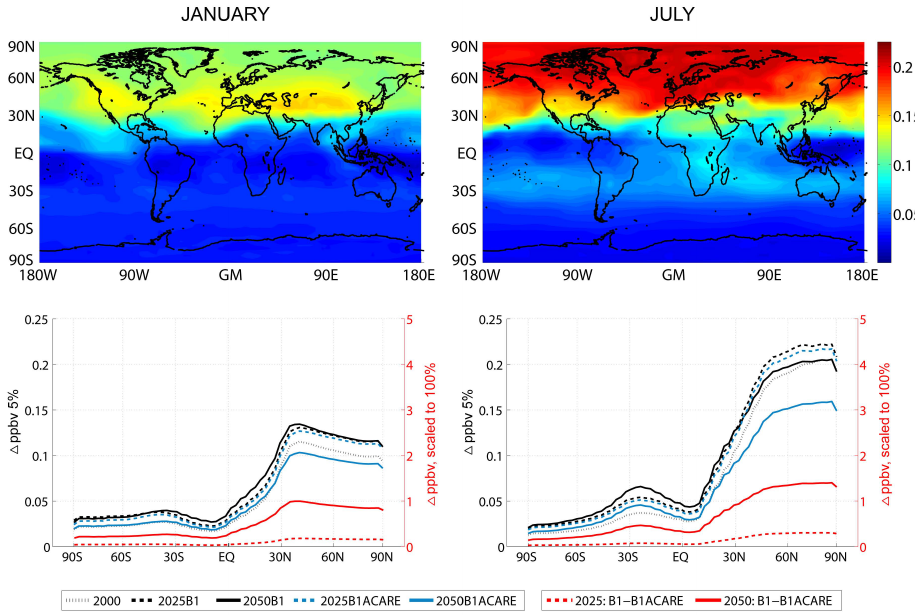
Fig. 6. Mean perturbations of ozone ( 1 ppbv) in the upper troposphere (300–200hPa) during January (left) and July (right) for the 2050 B1 scenario (top) and as zonal means for all scenarios (bottom). The color bar and the left y-axis show the unscaled impact of the 5% perturbation of aircraft emissions (simulations BASE – AIR), while the red scales in the bottom figures are scaled up by a factor 20 from 5% to 100% and refer to all lines. The red lines show the difference between the B1 and B1ACARE scenarios and refer to the red axis only.